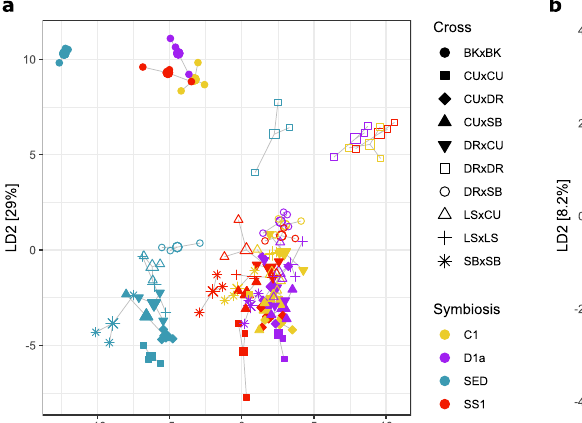
data(VSD)groupedbycross+symbiosis( a )andwiththeeffectofcrossremovedby limma ( b ). For each cross, origin of dams is denoted fi rst, and the origin of sires is